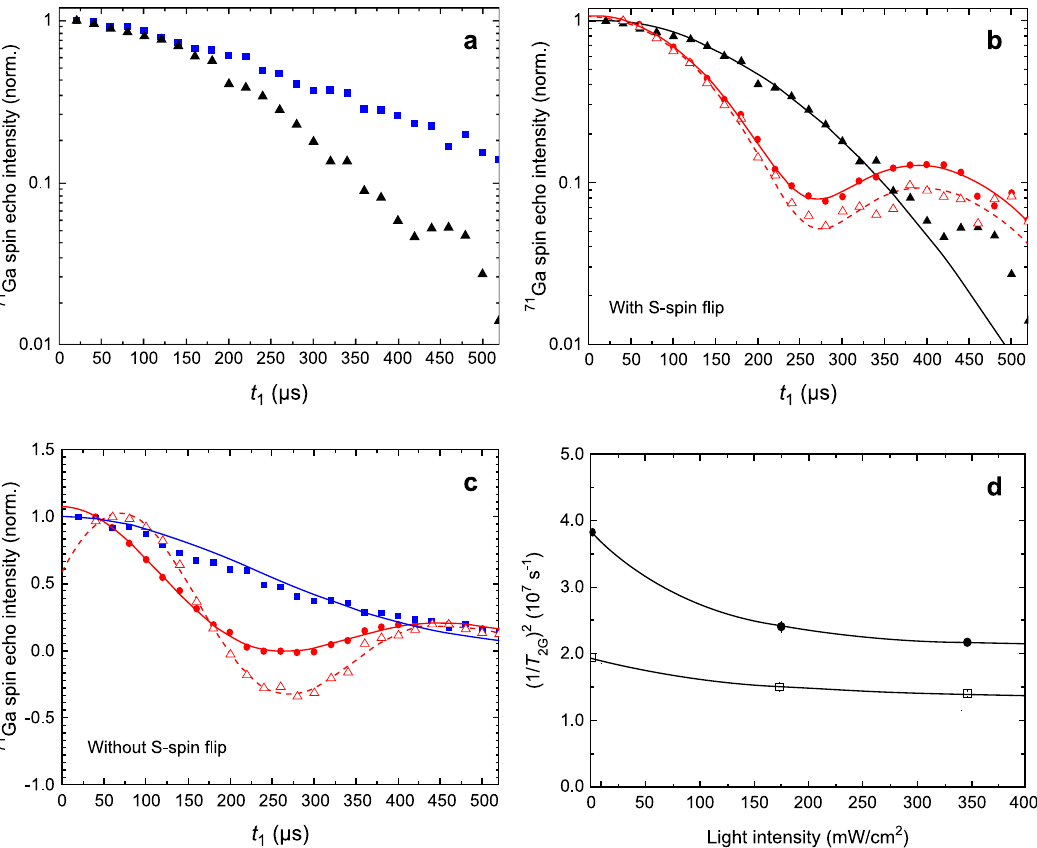
Fig. 3 Single- and double-resonance spin echo experiments under light illumination. a . [Spin echo decay in the dark]: Semi-log plots of the normalized spin-echo decay processes with ( ▲ ) and without ( ■ ) the S -spin fl ip (P3) pulse measured in the dark, with τ L ¼ 20 min at 10 K. b and c . [Spin echo decay under the light illuminations]: Normalized spin-echo decay processes with and without the S-spin fl ip (P3) pulse, respectively, measured under light illumination with τ L = 5 min at 10 K, along with the corresponding data in the dark shown in a . Solid circles ( ● ) and open triangles ( Δ ) represent those with the light intensities of approximately 173 and 346 mW cm − 2 , respectively. The vertical axis in c is shown on the linear scale to indicate the negative values in the range 200 – 340 μ s. d . [Light intensity dependence of the decay rate]: 1 = T 2G ð Þ 2 obtained by fi tting the data in b and c with Eq. (2), plotted as a function of the light power. Solid circles ( ● ) and open squares ( □ ) correspond to those with and without the S-spin fl ip (P3)